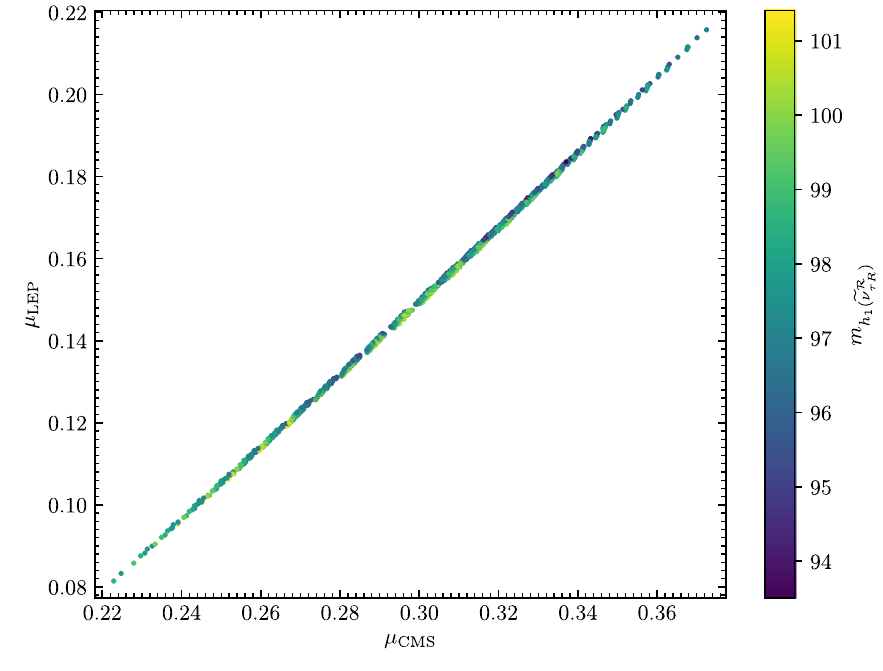
Fig. 10 Correlation of